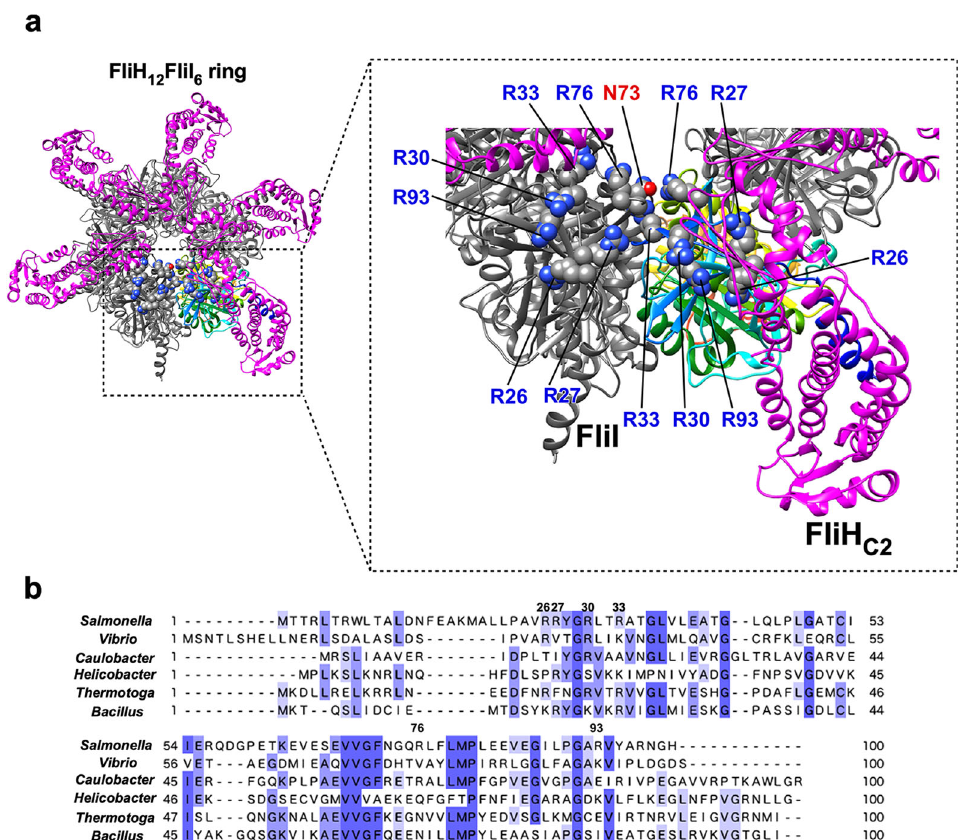
Fig. 2 Structural model for the cytoplasmic ATPase ring complex. a C α ribbon representation of the FliH 2 FliI complex (PDB ID: 5B0O). Arg-26 (R26), Arg-27 (R27), Arg-30 (R30), Arg-33 (R33), Arg-76 (R76), and Arg-93 (R93) form a positive charge cluster on the molecular surface of the N-terminal domain of FliI. The C-terminal domain of FliH forms a dimer (FliH C2 ) to bind to the N-terminal α -helix consisting of residues 2 – 21 of FliI and the positive charge cluster. Arg-33 and Arg-76 are located at an interface between FliI subunits, and Arg-76 is in very close proximity of Asn-73 (N73) of its nearest FliI subunit. b Multiple sequence alignment of the N-terminal domain of FliI orthologs. Multiple sequence alignment was carried out by Clustal Omega. Conserved residues are labeled with blue colors. UniProt Accession numbers: Salmonella , P26465; Vibrio , A0A1Q1PM95; Caulobacter , B8H363; Helicobacter , O07025, Thermotoga , A0A2N5RHQ8; Bacillus ,